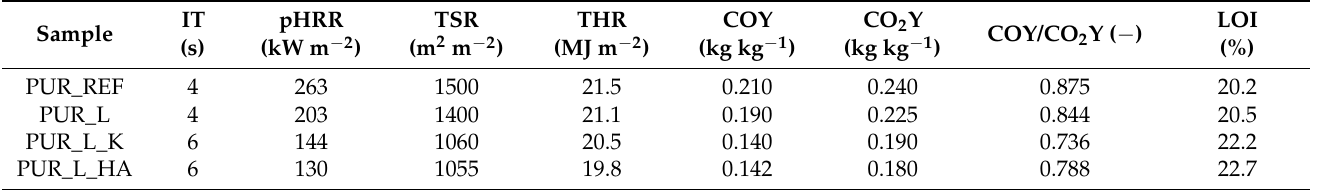
Table 5. Flame retardant properties of PUR composites.